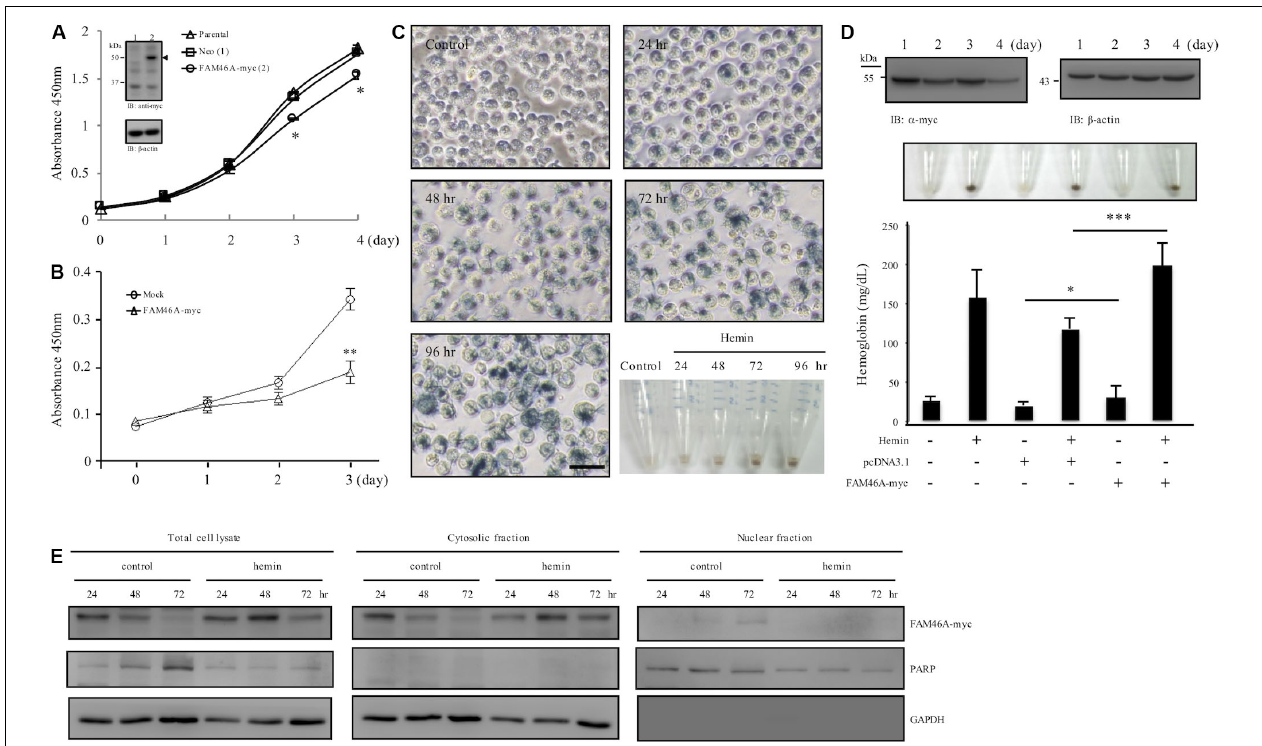
FIGURE 6 | FAM46A inhibits cell growth and promotes hemin-induced hemoglobinization. (A) Comparison of the cell growth curve of different HeLa cell populations as indicated. Inset showed the WB analysis of FAM46A protein (arrowhead) expression in HeLa cells stably expressing FAM46A (lane 2). The Neo-control HeLa cell (lane 1) was included as a control ( n = 3, mean ± SD; ∗ p < 0.05). (B) Comparison of the cell growth curve of K562 cells either mock-transfected or transiently transfected with the FAM46A-myc construct ( n = 4, mean ± SD; ∗∗ p < 0.01). (C,D) Analysis of hemin-induced erythroid differentiation of K562 cells. Cells were treated with hemin (50 µ M) and cultured for up to 4 days, followed by benzidine staining as described in section “Materials and Methods” (C) . Cells were observed under microscopy and photographs were taken to show stain-positive cells representing differentiated cells (blue). Scale: 50 µ m. The lower right panel shows the cell pellets collected at different time points as indicated. (D) The effect of FAM46A expression in K562 cell differentiation. Top panel: WB analysis of FAM46A expression in transiently transfected K562 cells. FAM46A was detected by the anti-myc Ab, while β -actin was used as a loading control. Middle panel: photographs of cell pellets showing stain-positive differentiated cells (blue). Lower panel: Analysis of hemoglobin production in transfected K562 cells treated with or without hemin at day 3 post transfection ( n = 3, mean ± SD; ∗ p < 0.05, ∗∗∗ p < 0.001). (E) Western blot analysis of the subcellular distribution of the FAM46A protein in K562 cells treated with or without hemin at different time points as indicated. Expression of GAPDH and PARP is used as a marker for the cytosolic and nuclear fractions,